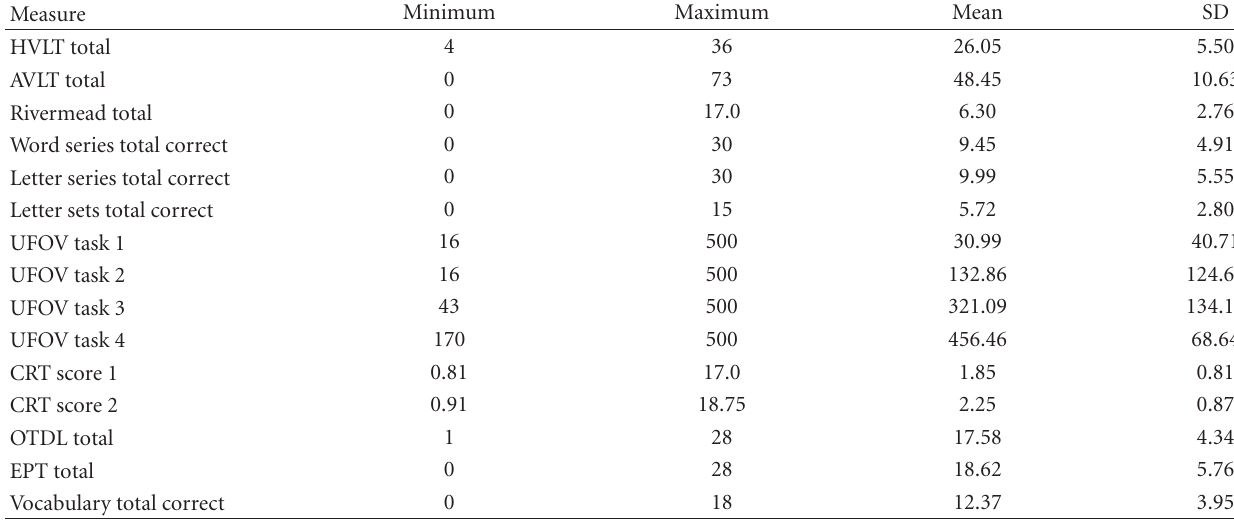
Table 1: Minimum, maximum, and mean scores (SD: standard deviation) for the ACTIVE sample on measures of baseline